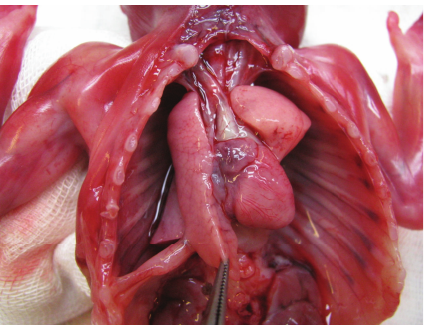
Figure 3: Anatomical postmortem exam of the fetus showing pulmonary hypoplasia and right heart axis